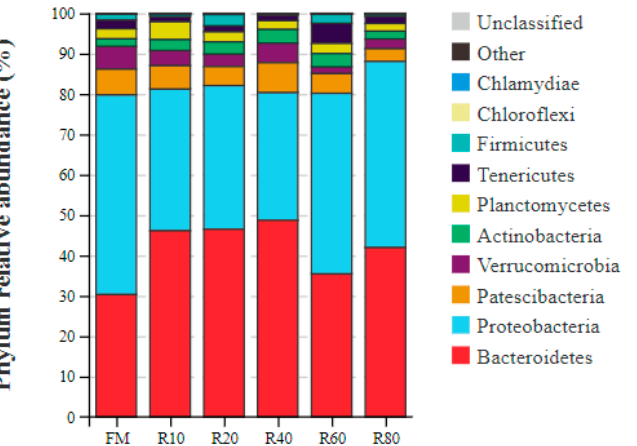
Figure 3. Composition of the intestinal microflora for juvenile shrimp L. vannamei at phylum level.